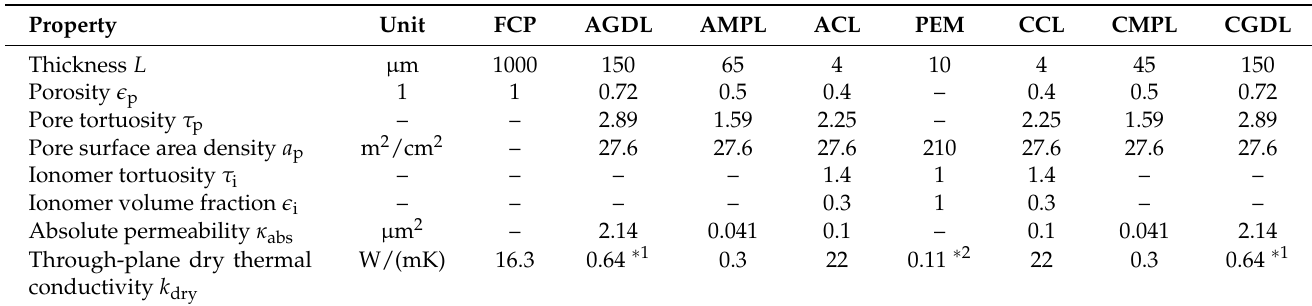
Table A1. Properties of the model domains.